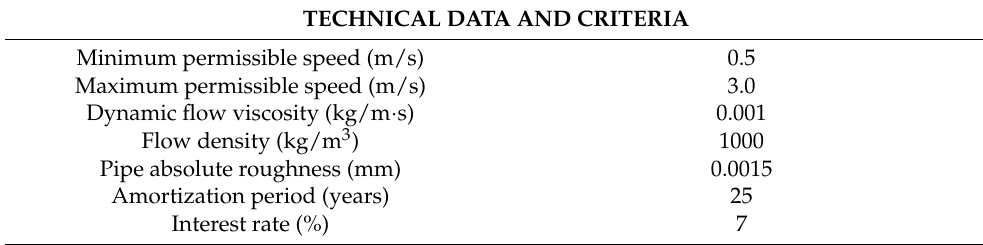
Table 1. Data and criteria for the design of irrigation networks.